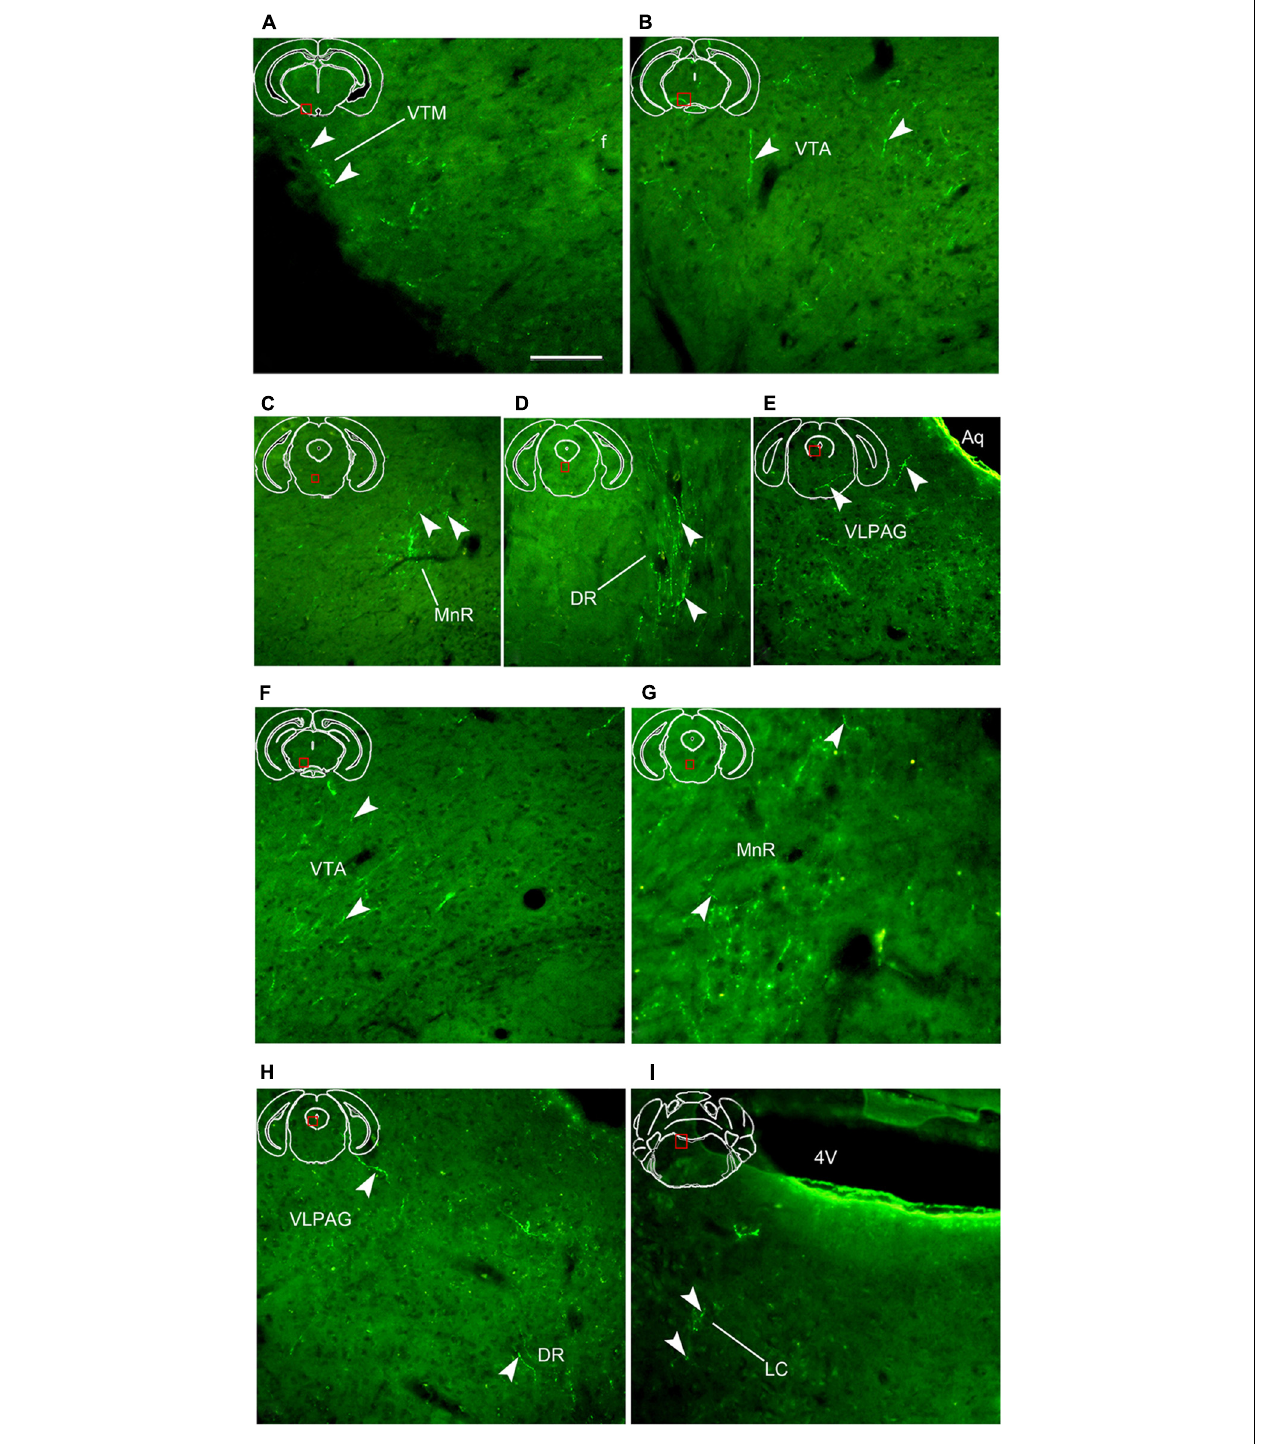
AcbC (M-7). (F–I) Axons with varicosities invade the ventral tegmental area [ (F) ,VTA], the medial raphe nucleus [ (G) , MnR], the dorsal raphe nucleus [ (H) , DR], the ventrolateral periaqueductal gray [ (H) ,VLPAG], and the locus coeruleus [ (I) , LC] following the injection of AAV-lox-hrGFP into the mAcbSh (M-22). Arrowheads indicate varicosities. Abbreviations: 4V, forth ventricle; Aq, aqueduct; f, fornix. Scale bar = 100 μ